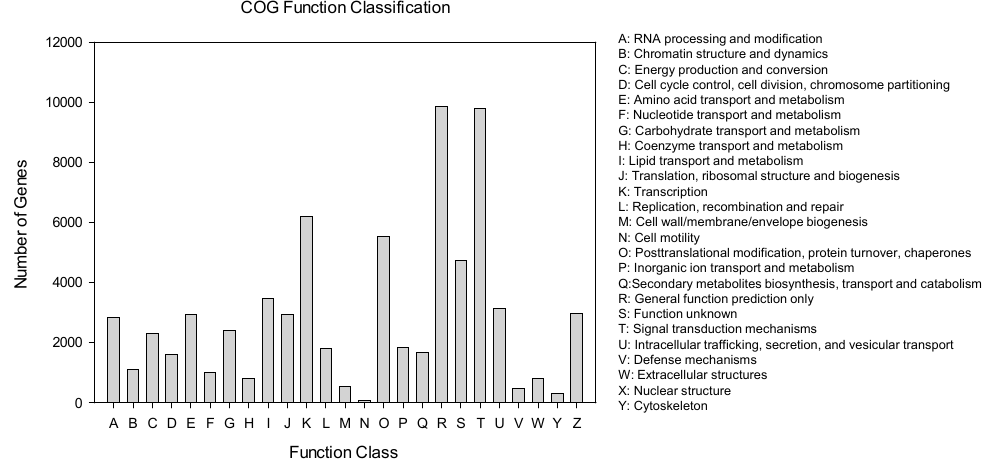
Figure 5. Clusters of Orthologous Groups (COG) functional categories of the unigenes annotated in the current study. The names of each class definition (A to Y) are provided on the right side of the figure.